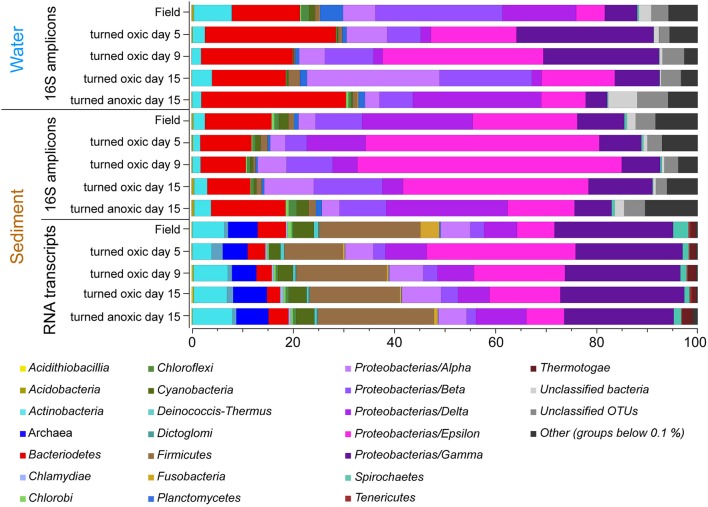
Stacked bar graphs of partial 16S rRNA gene sequences from the water phase and the sediment surface (top 1 cm) collected in the field and throughout the incubation experiment. Averages of relative abundances are shown (n = 3, except “turned oxic” water day 9, n = 2; and “turned oxic” water and sediment day 15, n = 4). The bottom stacked bars show the microbial community derived from UniProtKB/Swiss-Prot reference organisms linked to annotated genes derived from the RNA transcripts (relative proportion of FPKM). Proteobacteria have been divided into classes and low abundant groups (< average 0.1% for all samples have been grouped as “Others”).